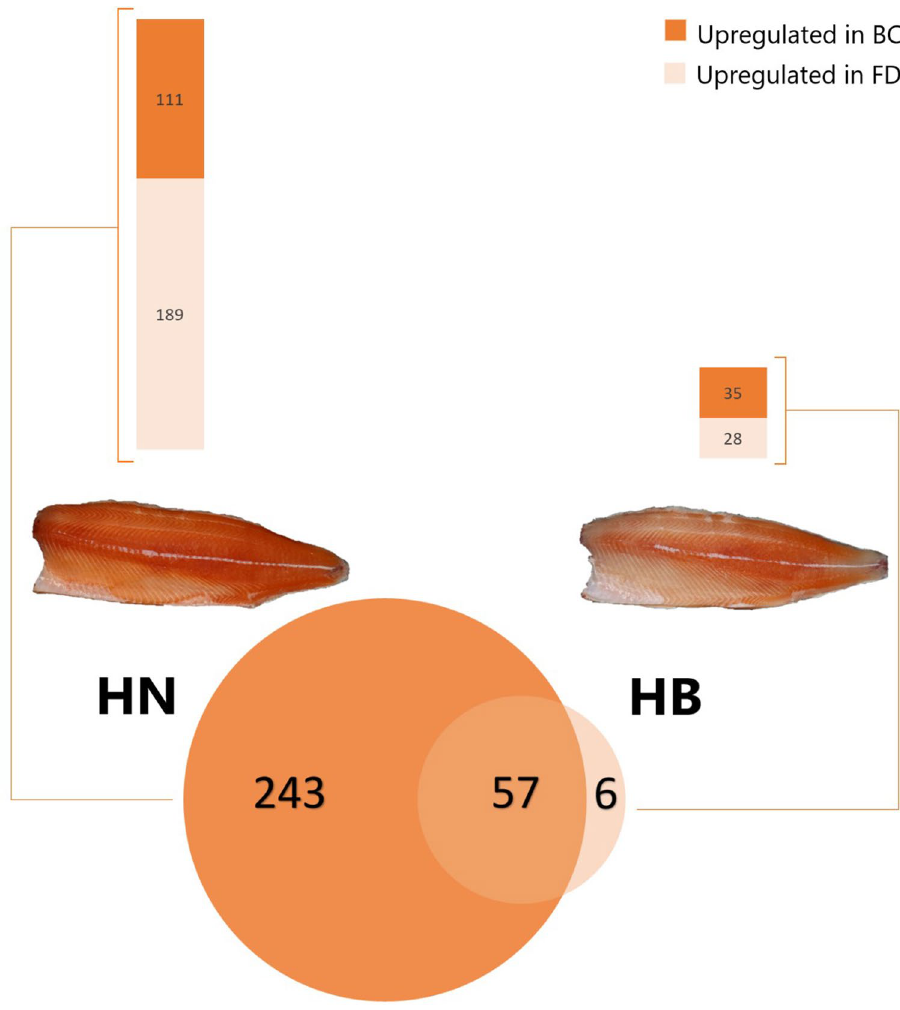
Figure 6. Visualization of differentially expressed genes (DEGs) between high red color-no banding (HN) and high red color-banded (HB) fish when comparing the back central (BC) and front dorsal (FD) muscle regions. Venn diagram (created by InteractiVenn 75 ) showing the overlapping DEGs between HN and HB groups and the number of DEGs in HN and HB groups is presented in the bar